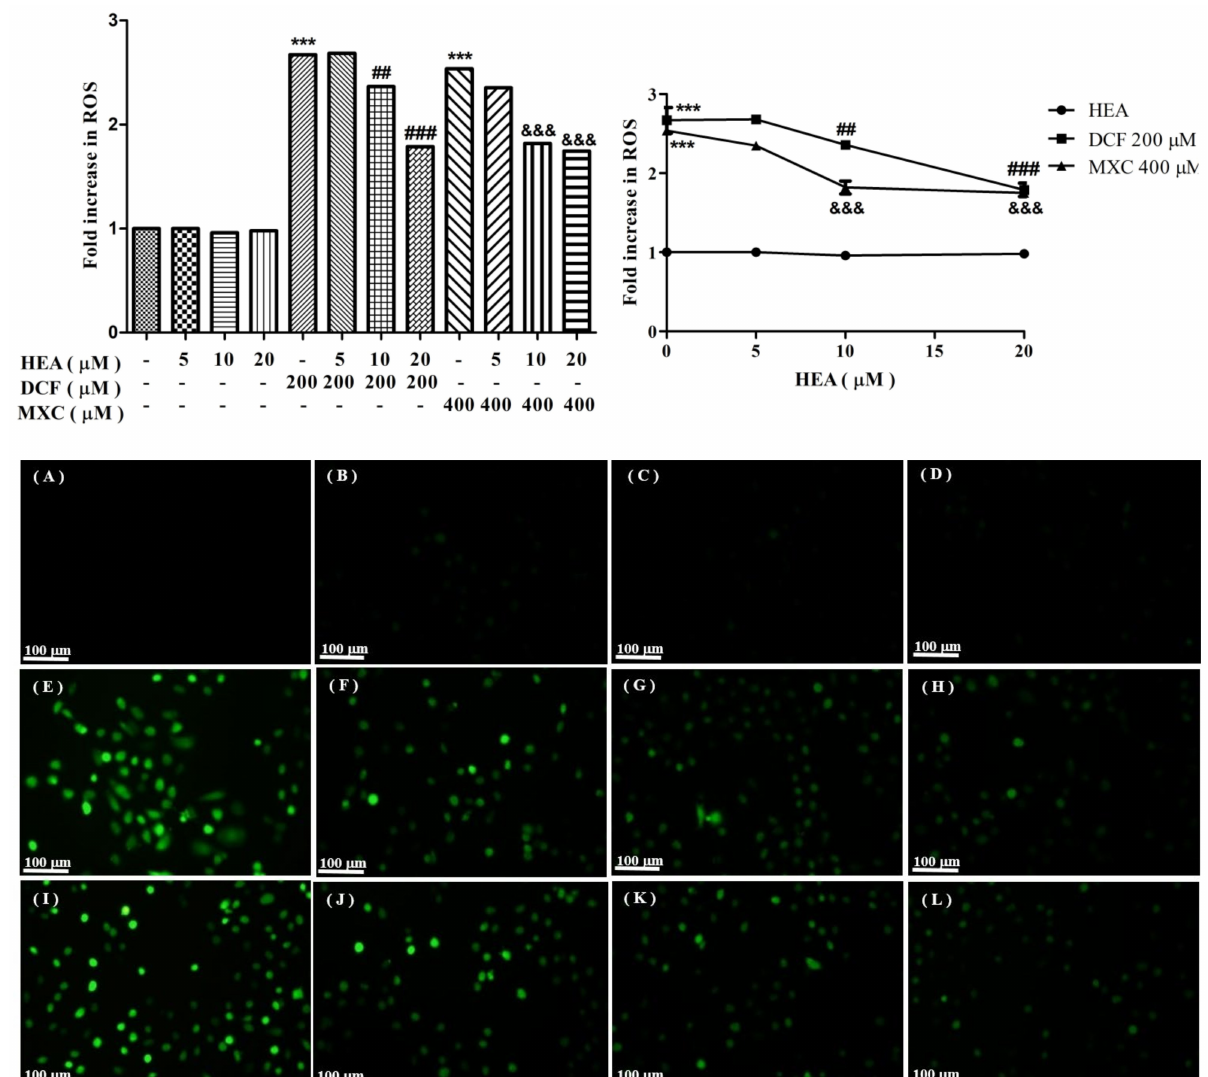
Figure 3. Intracellular ROS induced by DCF and MXC attenuated by HEA. HK–2 cells, pretreated with or without HEA (5, 10 and 20 µ M) for 30 min before exposure to DCF (200 µ M) and MXC (400 µ M) for 4 h, were stained with DCFH-DA and assessed by phase contrast fluorescence microscopy (original magnification, × 100). ( A ): control. ( B ): HEA 5 µ M. ( C ): HEA 10 µ M. ( D ): HEA 20 µ M. ( E ): DCF 200 µ M. ( F ): DCF + HEA 5 µ M. ( G ): DCF + HEA 10 µ M. ( H ): DCF + HEA 20 µ M. ( I ): MXC 400 µ M. ( J ): MXC + HEA 5 µ M. ( K ): MXC + HEA 10 µ M. ( L ): MXC + HEA 20 µ M. Values are expressed as mean ± SD (*** p < 0.001 versus the control group; ## p < 0.01 versus the DCF group; ### p < 0.001 versus the DCF group; &&& p < 0.001 versus the MXC